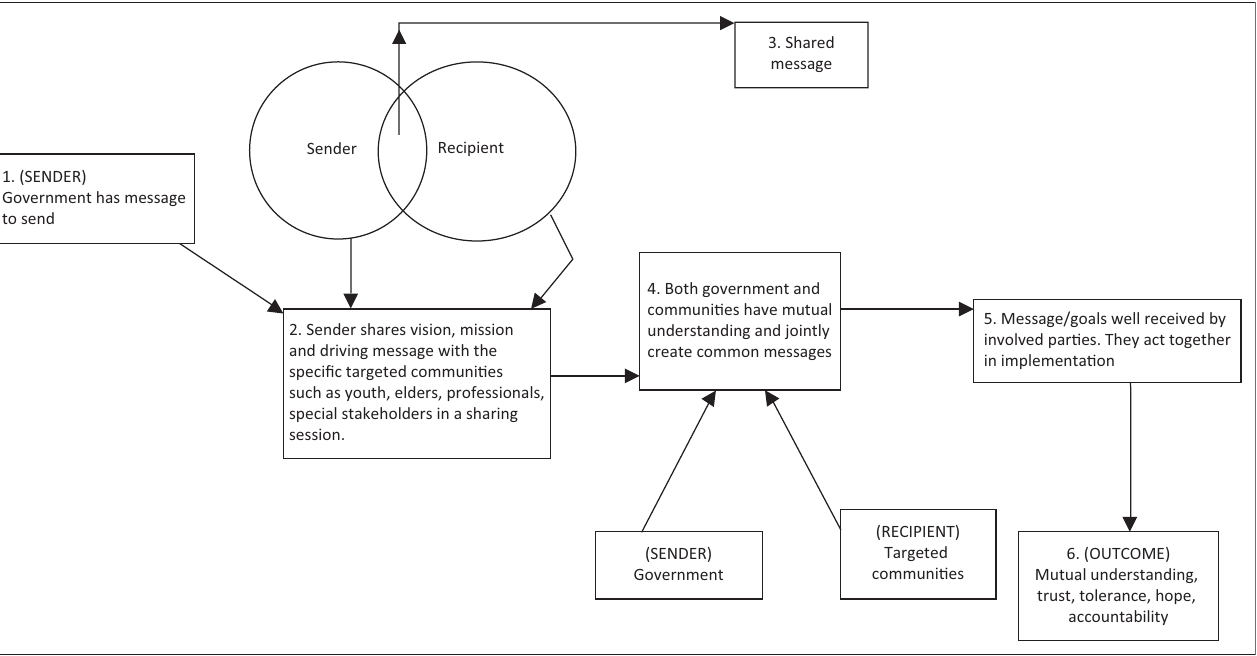
FIGURE 1: A model of effective communication for rural